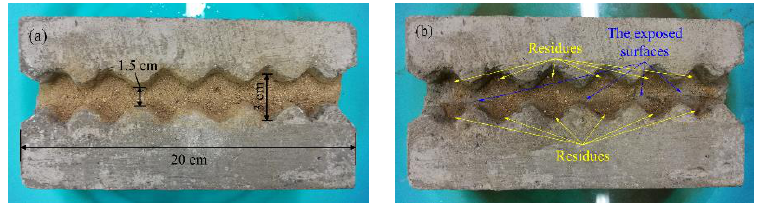
Figure 13. Experiment results: ( a ) the initial sample; ( b ) the sample after the experiment.